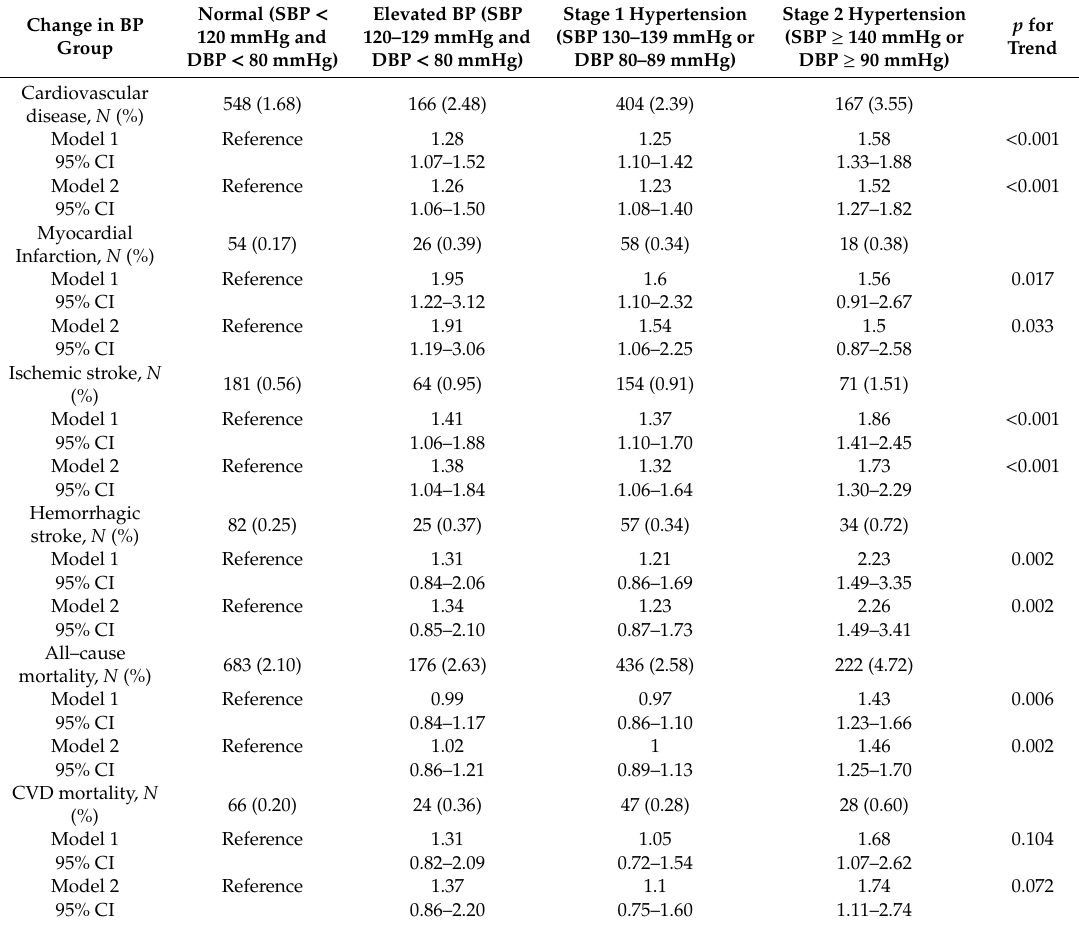
Table 2. Associations between change in blood pressure according to the 2017 ACC / AHA high blood pressure guideline and risk of cardiovascular disease, myocardial infarction, stroke, and mortality. Elevated BP (SBP Stage 1 Hypertension Normal (SBP < Change in BP 120–129 mmHg and (SBP 130–139 mmHg or 120 mmHg and Group DBP < 80 mmHg) DBP < 80 mmHg) Cardiovascular disease, N